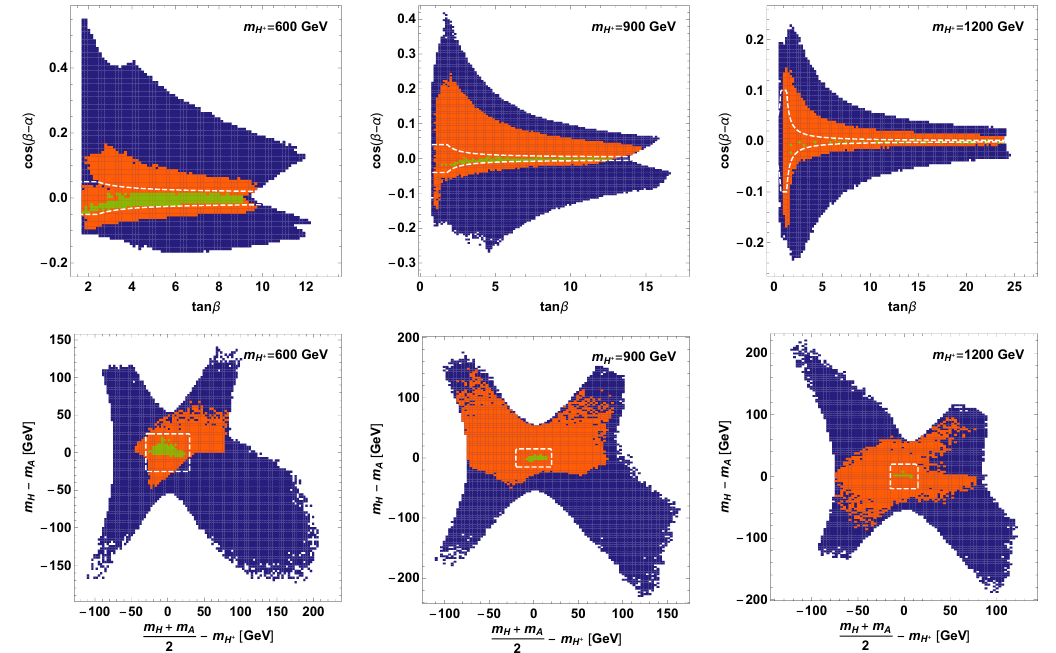
Figure 4 . Binned plots of allowed data points. The left, the middle and the right panels correspond to the parameter slices of (i), (ii) and (iii), respectively. All the colored points satisfy the low energy constraints. The orange and the green points satisfy the perturbative unitarity conditions until the Planck scale. The green points satisfy the vacuum stability condition. The regions surrounded by the white dashed lines are used in (cid:12)gure